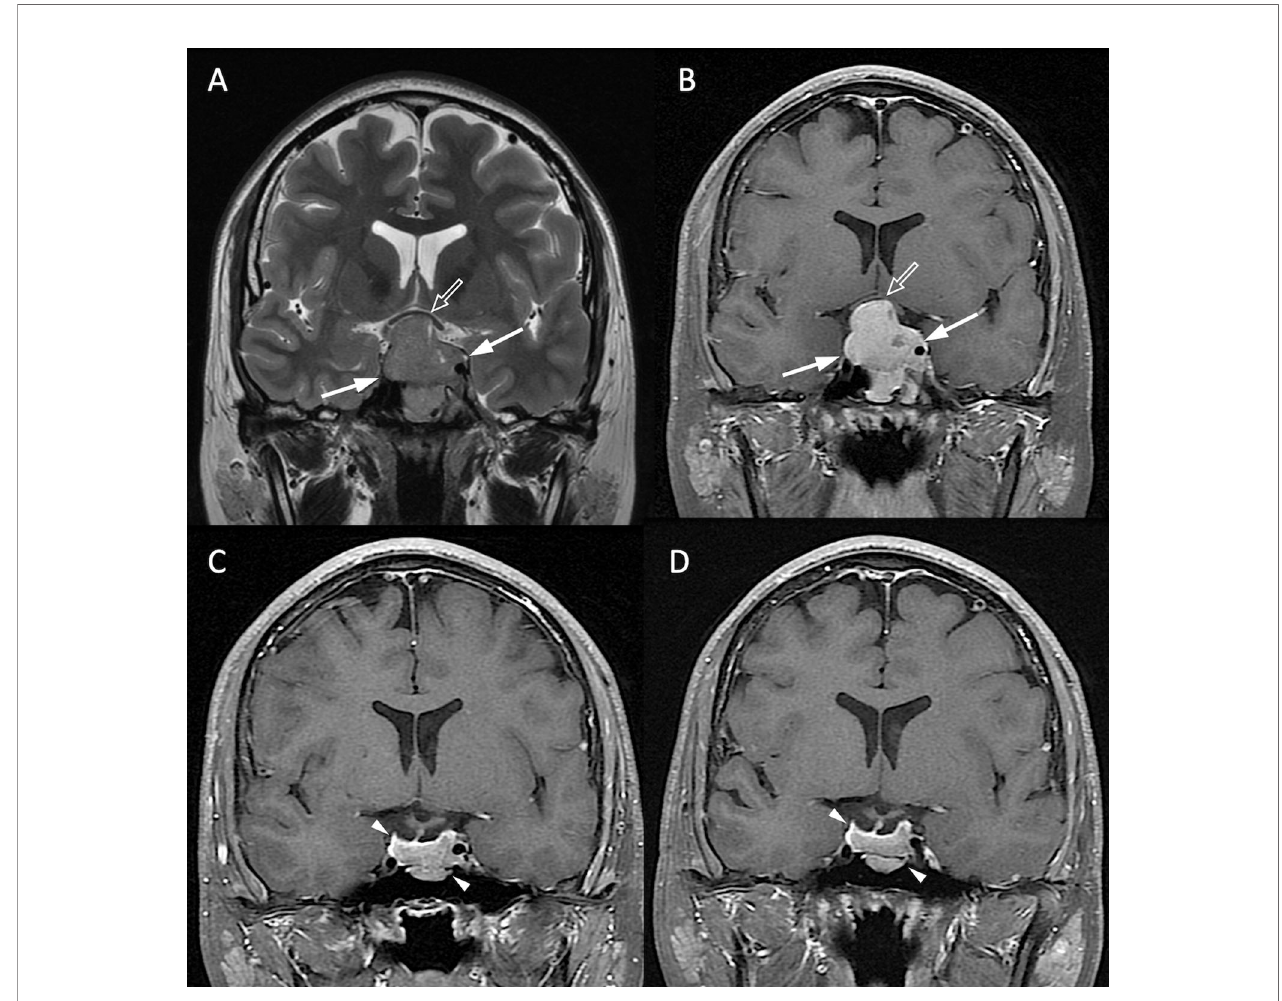
FIGURE 4 | NFPA without P/R. A 20-year-old male patient with blurred vision and pathologically con fi rmed NFMA. (A, B) Coronal T2WI (A) and CE T1WI (B) show a NFMA (white arrows) with upward suprasellar extension, causing compression of the optic chiasm and the third ventricle (open arrow). (C) Subtotal tumor resection via TSA was performed, and the residual tumor (arrowheads) was observed. (D) No progression of the residual tumor (arrowheads) was observed 48 months after surgery.